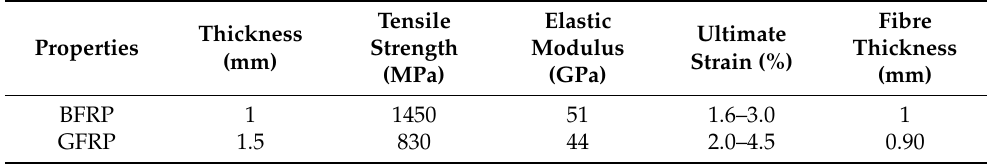
Table 4. Properties of the fibre